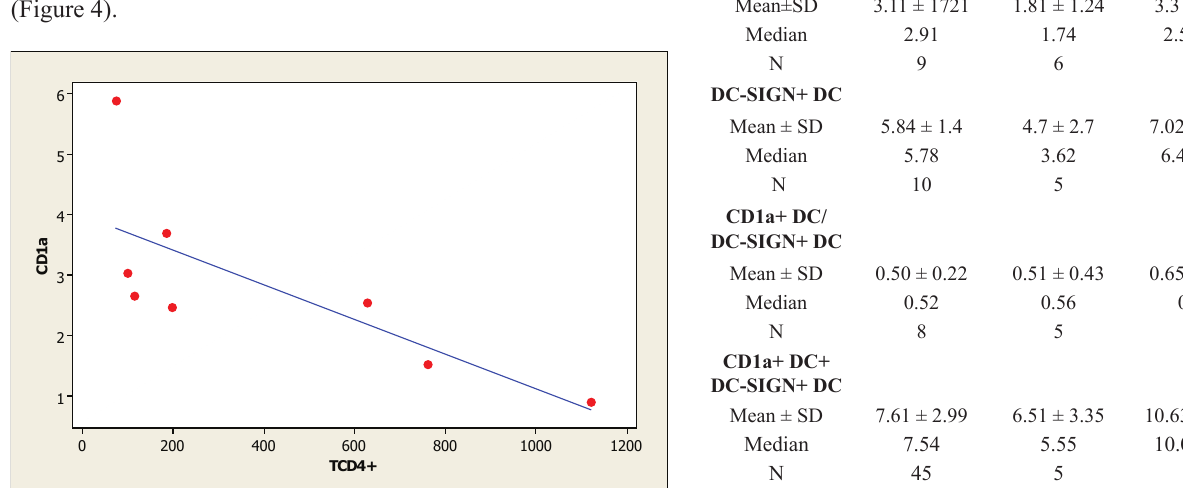
FIGURE 4 - Correlation between CD1a+DC and the levels of CD4+T (10 6 cells/l) in patients with AIN II/III. N=8, l=liter, DC=dendritic cells, CD1a=cluster of differentiation type1a.